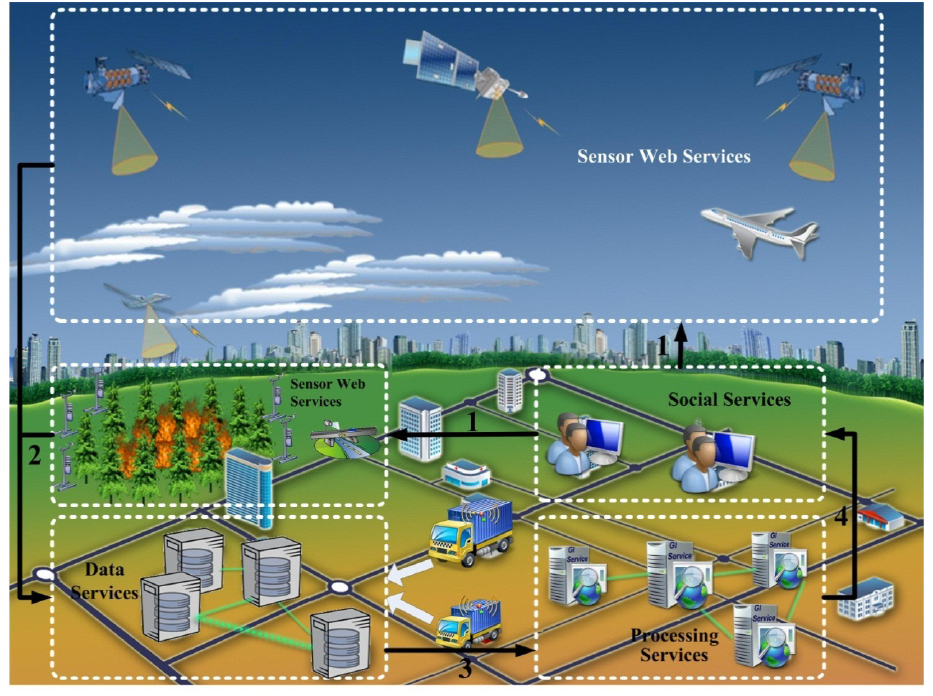
Figure 3. An example of PGIS application response to a fire